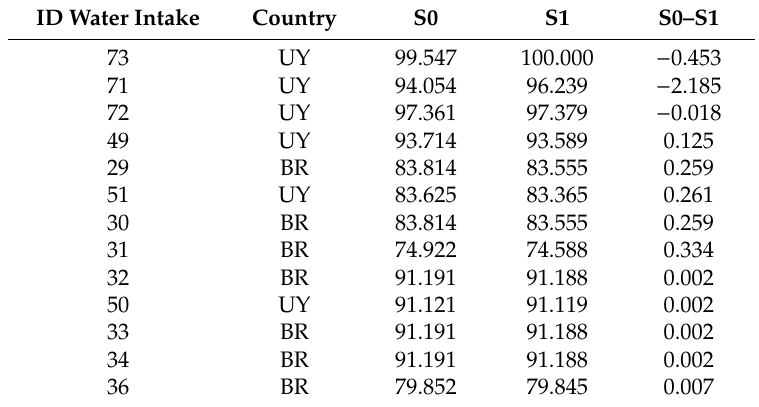
Table 9. E ffi ciency of water intakes (%) and comparison of the two selected